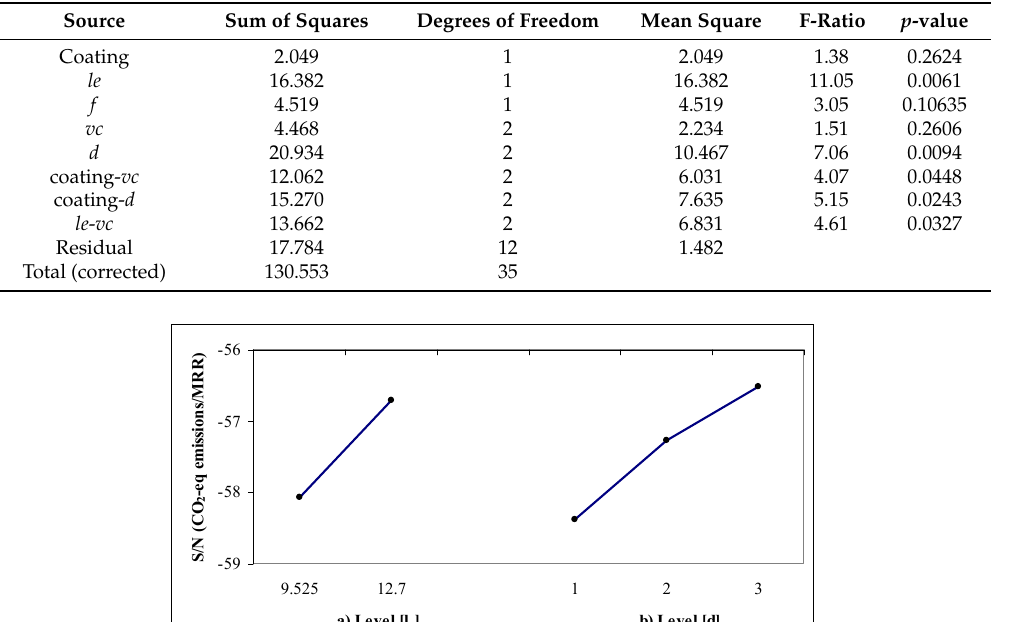
Table 8. ANOVA of the S/N ratio (CO 2 -eq emissions/MRR).